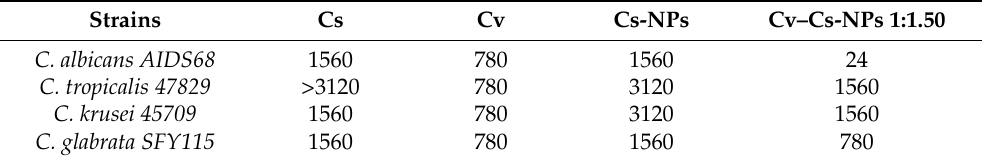
Table 3. MIC Antimicrobial activity of chitosan–carvacrol nanoparticles (CV–CS NPs) against Candida spp. The concentrations of the different compounds are expressed as µ g/mL.